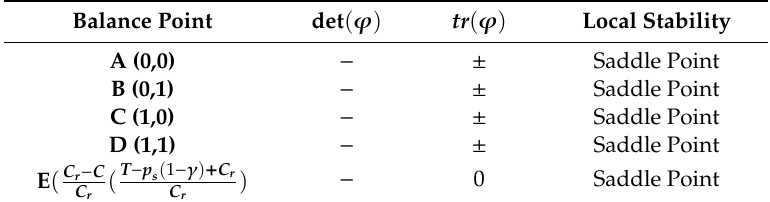
Table 4. Stability analysis of Case 2.